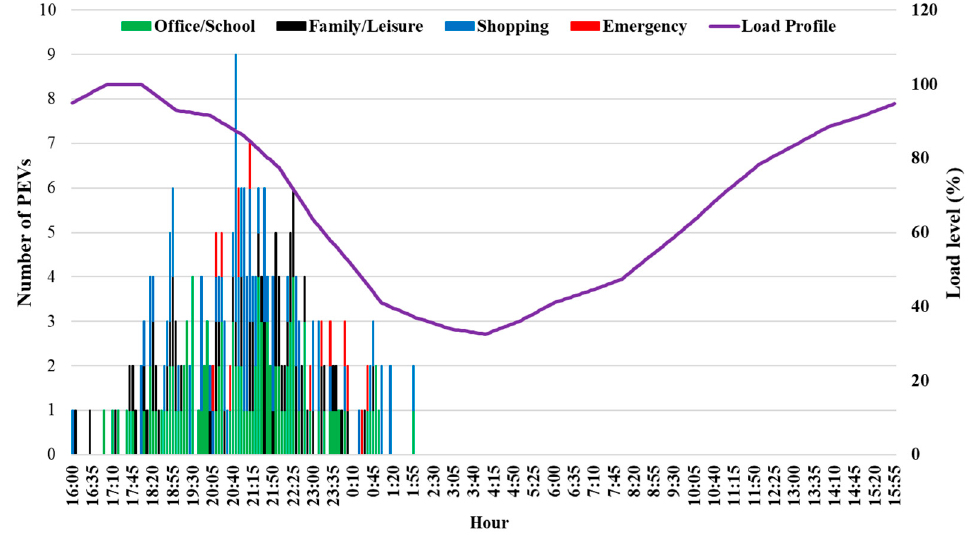
Figure 3. Daily load profile and PEVs arrival at charge point at 63% penetration.